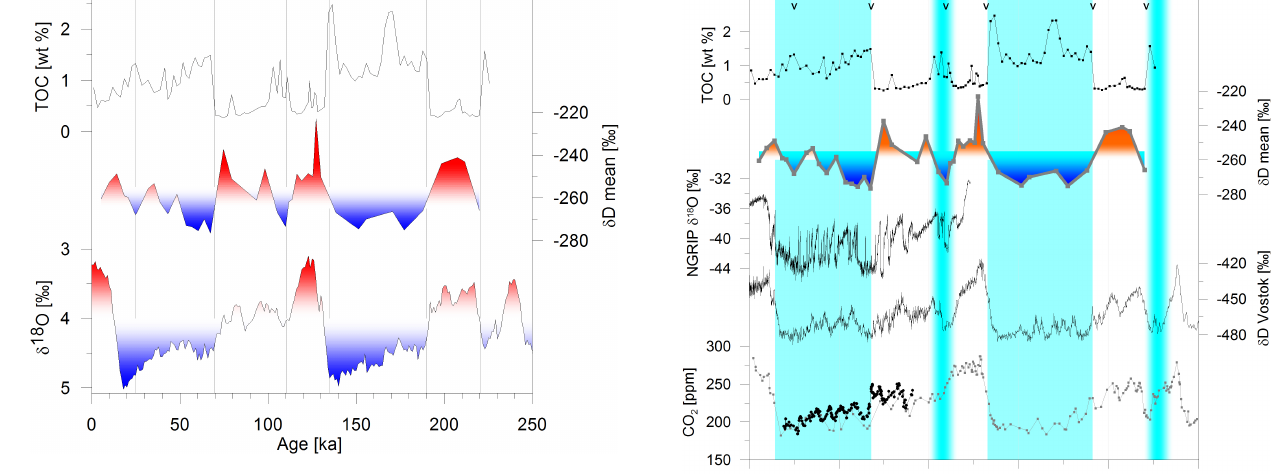
Fig. 3. Comparison of the TOC and δ D record from the Tumara Pa- leosol Sequence with the marine δ 18 O stack (Lisiecki and Raymo, 2005). The vertical grey lines mark the tie points chosen for the age-depth model.